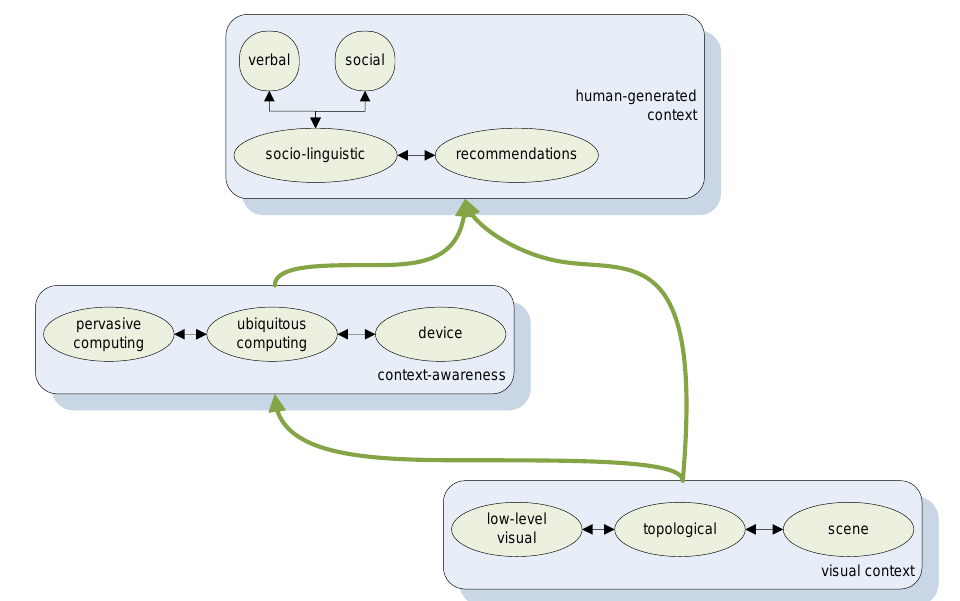
Figure 2. Diagrammatic scheme of identified contextual types.